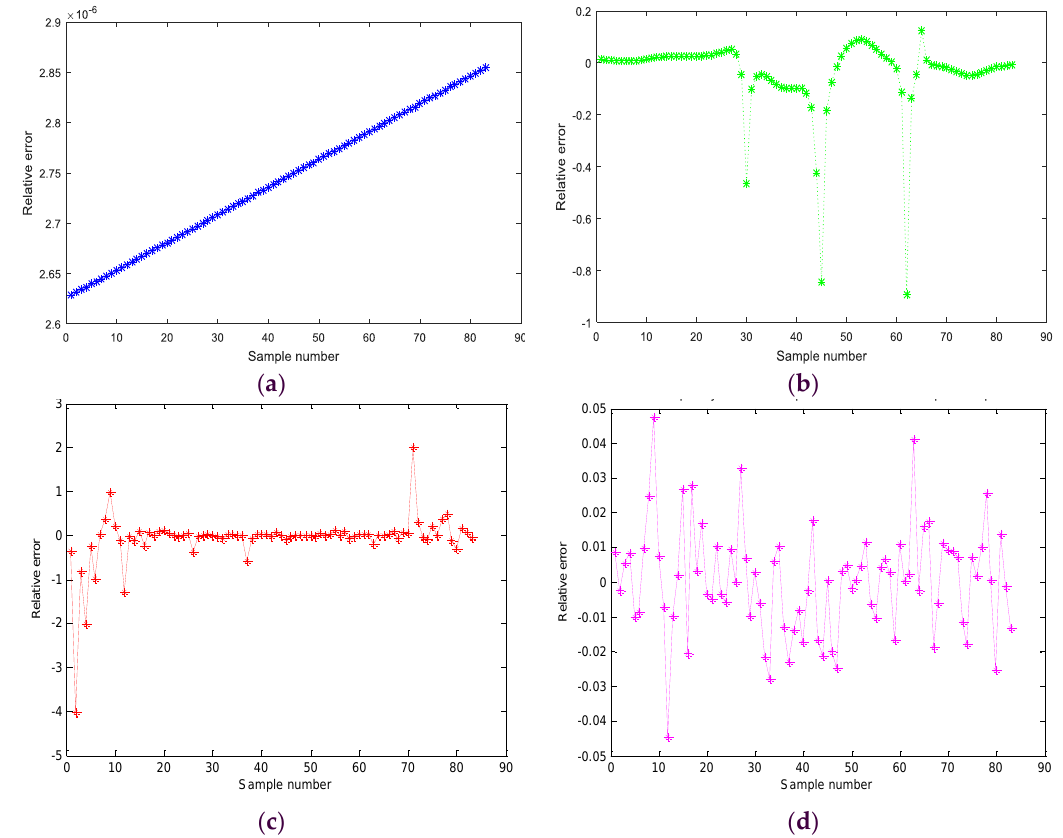
Figure 6. The relative errors of the three components and the carbon price sequence. ( a ) Extreme learning machine (ELM) prediction of the trend component; ( b ) Support vector machine (SVM) prediction of the low frequency component; ( c ) extreme learning machine whose input weights and bias threshold were optimized by particle swarm optimization(PSO-ELM) prediction of the high frequency component; ( d ) a multiscale ensemble forecasting model based on ensemble empirical mode decomposition (EEMD-ADD) prediction of the carbon price.